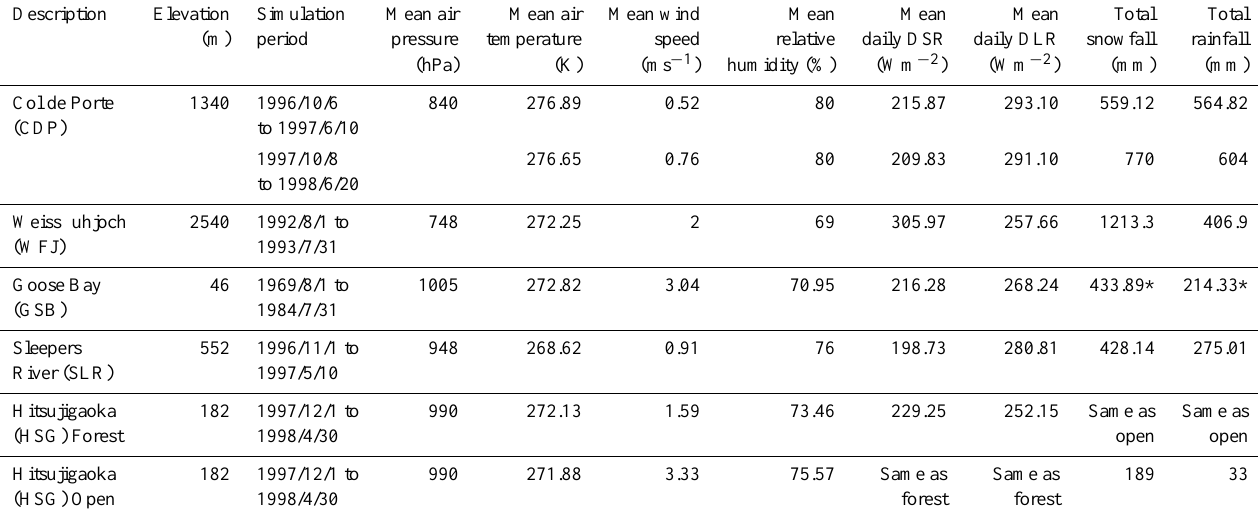
Table 2. Meteorological characteristics of study